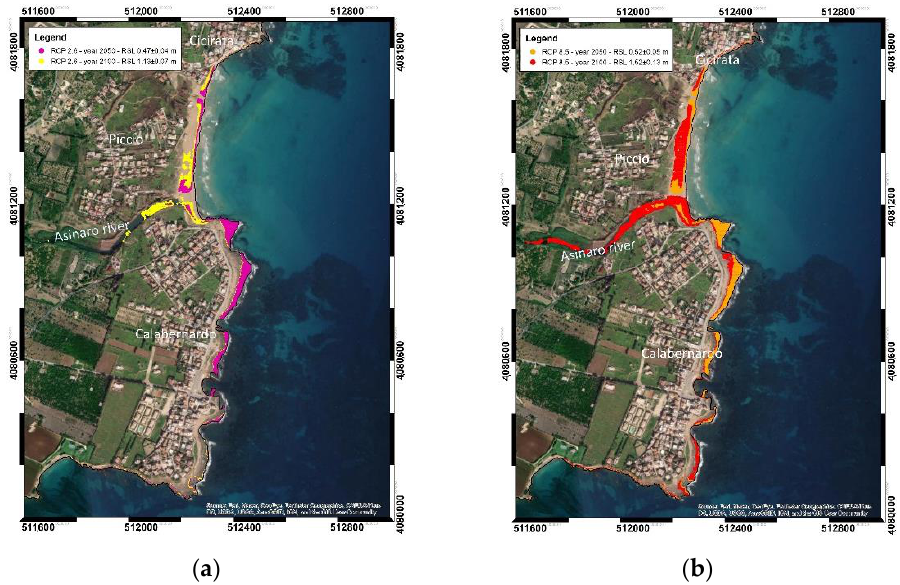
Figure 14. The bay of the Asinaro river mouth, near Piccio. In colors are reported the expected extension of land flooding in 2050 and 2100 for ( a ) RCP 2.6 and ( b ) RCP 8.5 climatic scenarios for a mean land subsidence at 8 ± 2.5 mm/yr. The expected maximum loss of land is 0.045 km 2 (high-resolution maps are inserted in Supplementary Materials Maps S10–S11).